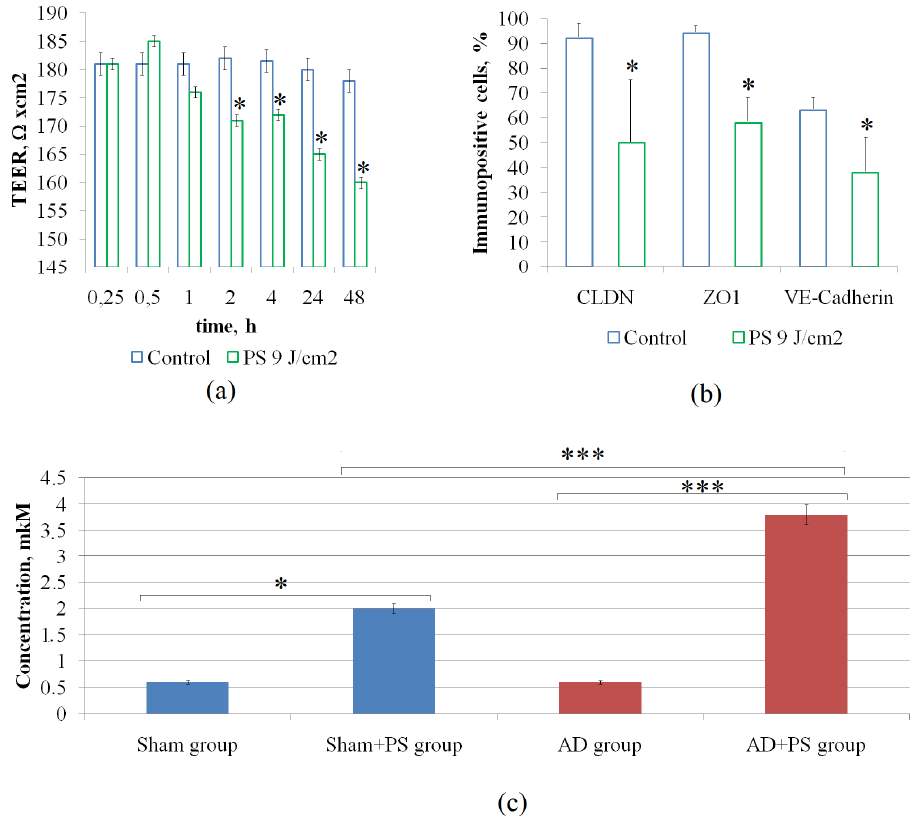
Figure 4. The PS-mediated effects on the blood-brain barrier (BBB) permeability: ( a ) and ( b ) The changes in transendothelial electrical resistance (TEER) and in the expression of tight junction (TJ) proteins before and after PS in normal mice, respectively; ( c ) The quantitative analysis of PS effects on the BBB permeability for fluorescent A β ; *— p < 0.05; ***— p < 0.001 vs. the sham groups, n = 15 for ( a ) and ( b ); n = 10 for ( c ).